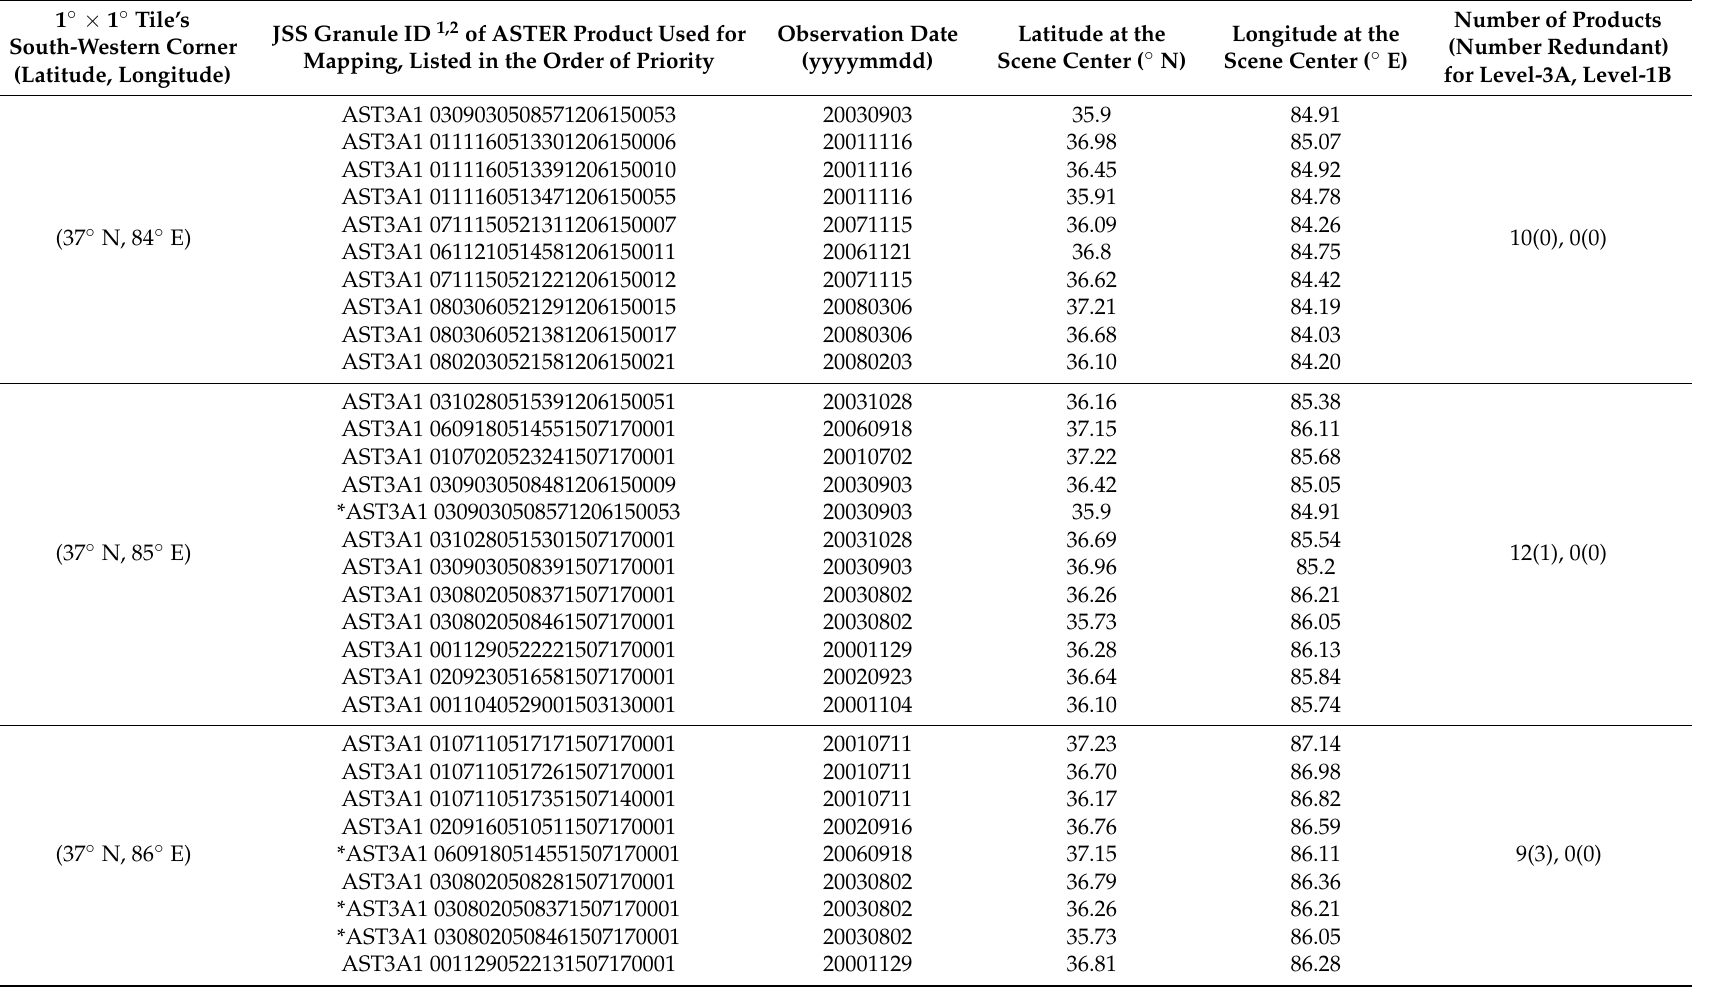
Table A1. The list of the ASTER products composing the produced regional maps (Figures 4 and